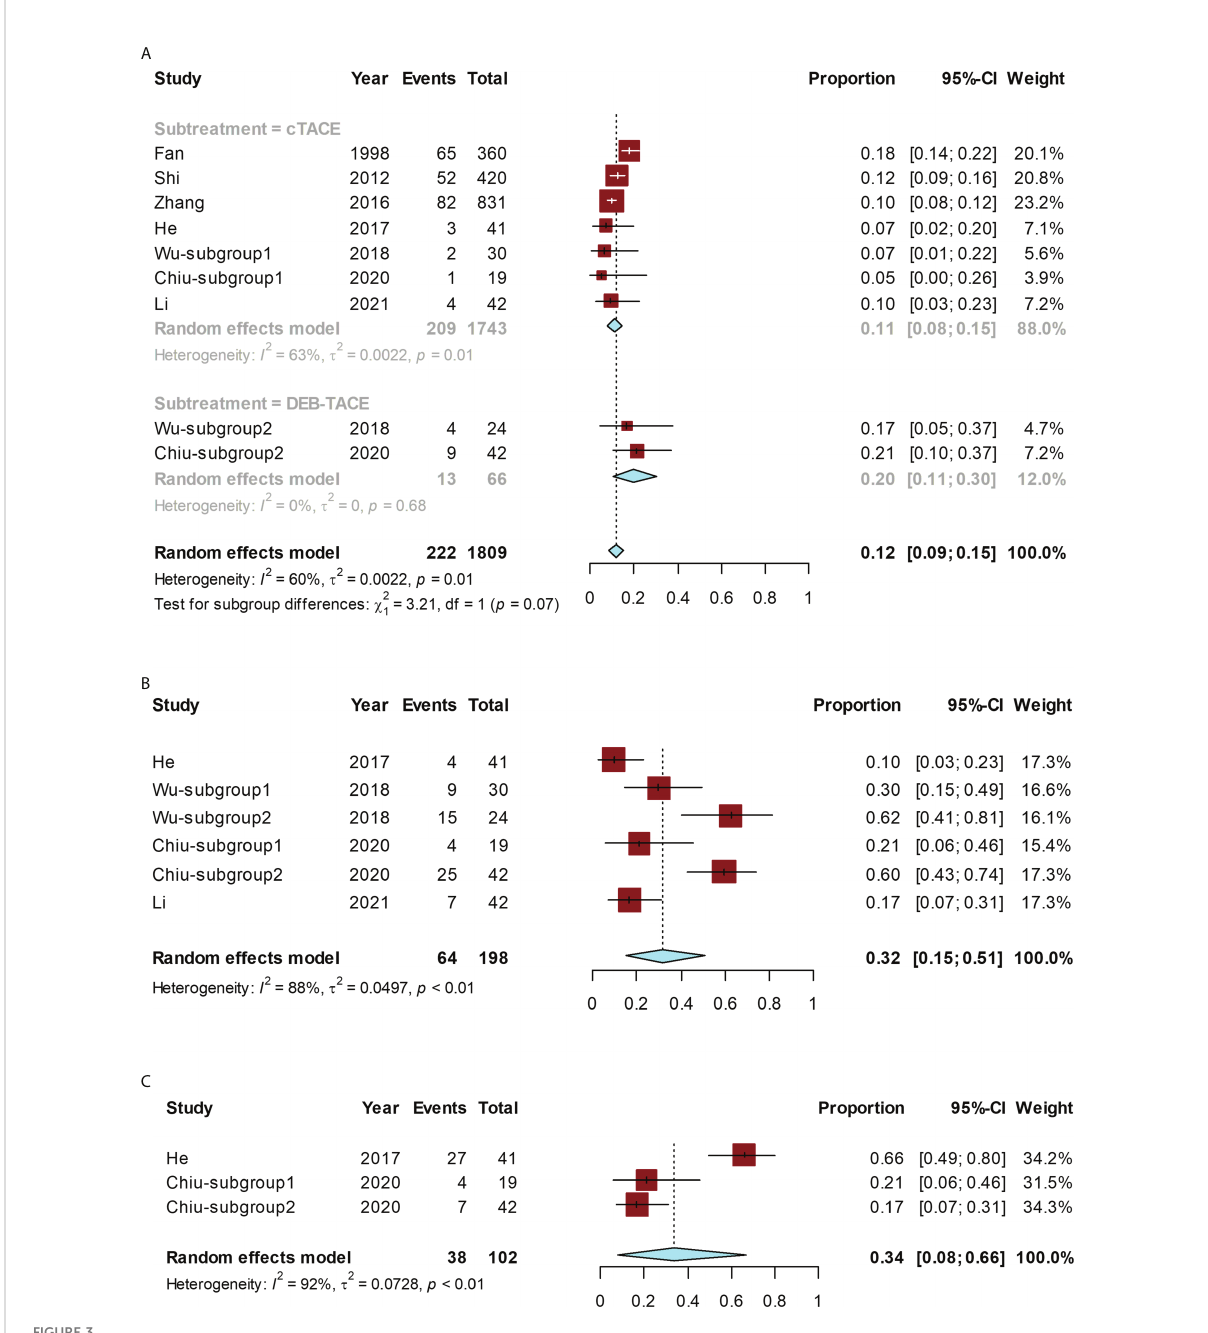
FIGURE 3 Forest plot for the TACE group. The pooled conversion rate and subgroup analysis of the conversion rate according to cTACE or DEB-TACE (A) , pooled ORR (B) , or pooled rate of grade ≥ 3 AEs (C) . cTACE, conventional transcatheter arterial chemoembolization; DEB-TACE, drug- eluding beads transarterial